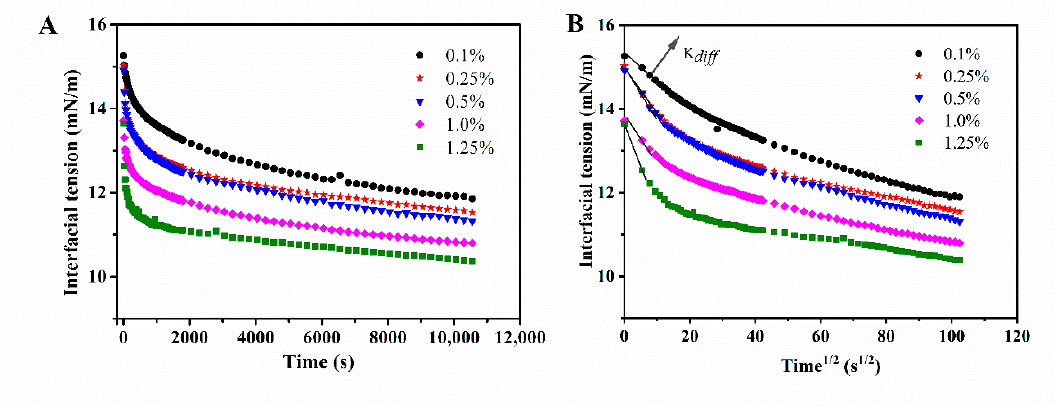
Figure 3. Interfacial behavior of WPI fibrils at the oil/water interface. ( A ) Time evolution of the interfacial tension ( γ ) for WPI fibrils (0.1–1.25 wt.%) at pH 2.0 and ( B ) dynamic interfacial tension vs. square root of time.